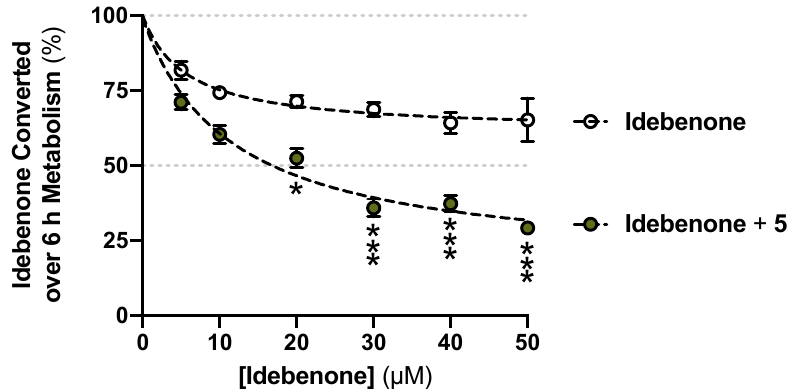
Figure 4. Reduced idebenone metabolism in the presence of the L -phenylalanine derivative 5 . Data was expressed as mean ± SEM from three independent experiments, with 4 data points each. Non-linear fits and two-way ANOVA were performed for comparisons between with or without 5 supplemented: *** p < 0.001, * p < 0.033.